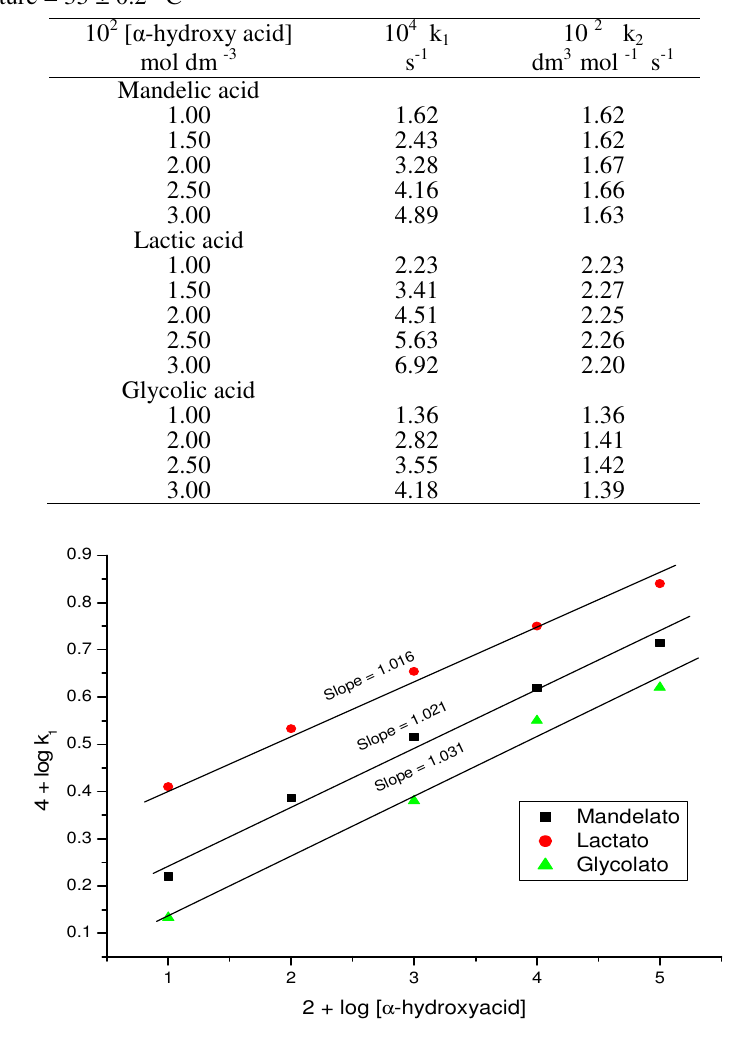
Table 6. First order values of the concentration of α -hydroxy acids in NaLS [H O ] = 2.00 x 10 -3 mol dm -3 , [H 2 2 Temperature = 35 ± 0.2 0 C